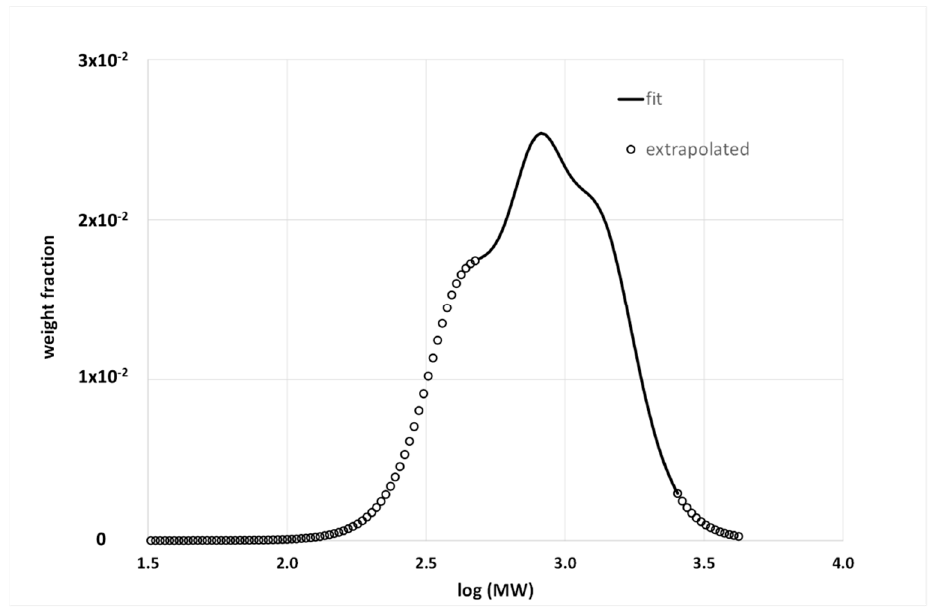
Figure 5. BMWD from the master curve reported in Figure 4.